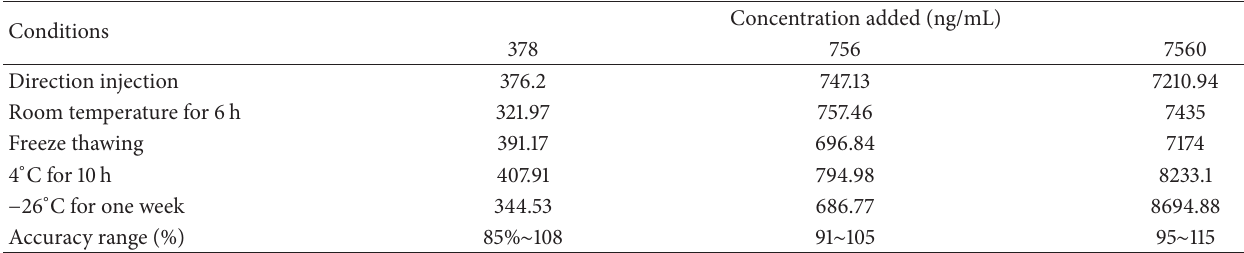
Table 3: Method stability of muscone in plasma.